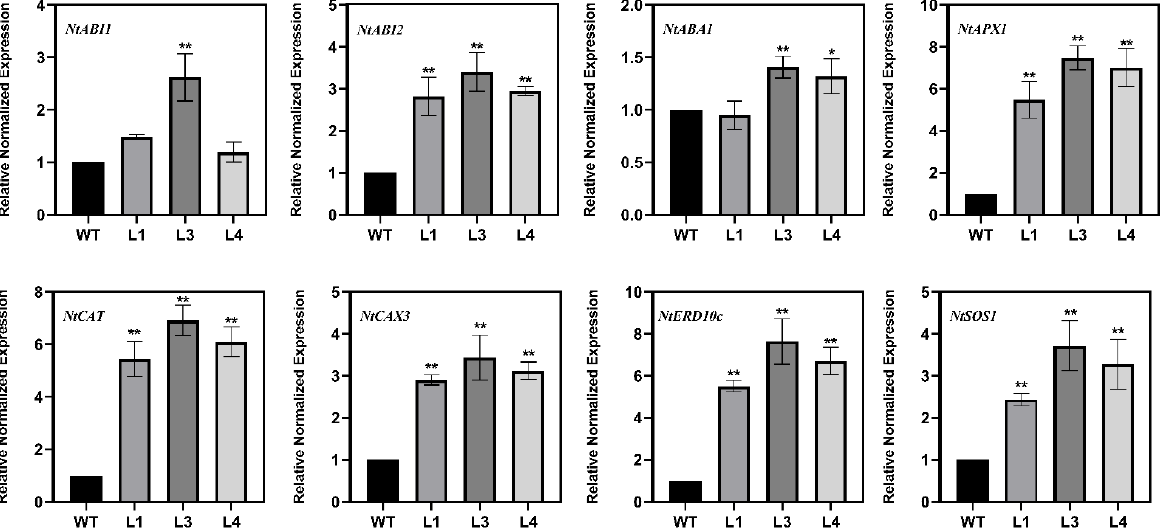
Figure 6. Expression analysis of stress related genes in 4-week-old seedlings of WT and LoSWEET14 transgenic tobacco leaves under normal condition. Each value indicates Mean ± SE (standard error). Asterisks indicate a significant difference ** p < 0.01 and * p < 0.05 compared with the corresponding